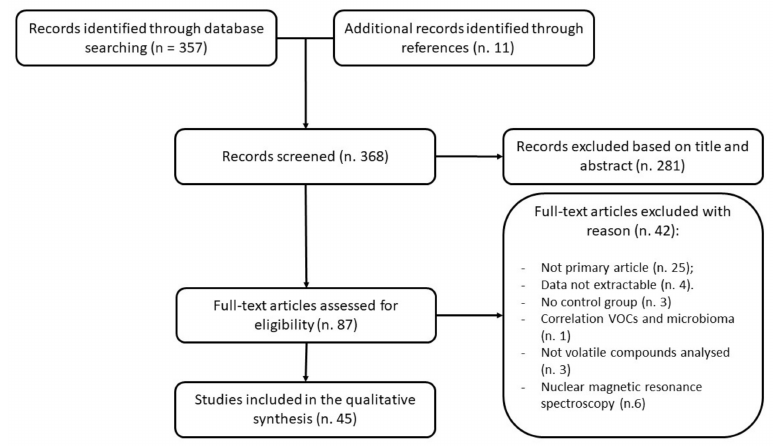
Figure 2. The PRISMA diagram reports the reasons for the exclusion of the articles. The specific VOCs identified in the included studies are reported in Table 1 for breath exhaled compounds, and in the caption of each table for fecal and urinary VOCs. Table 1. All breath test VOCs analyzed in each specific